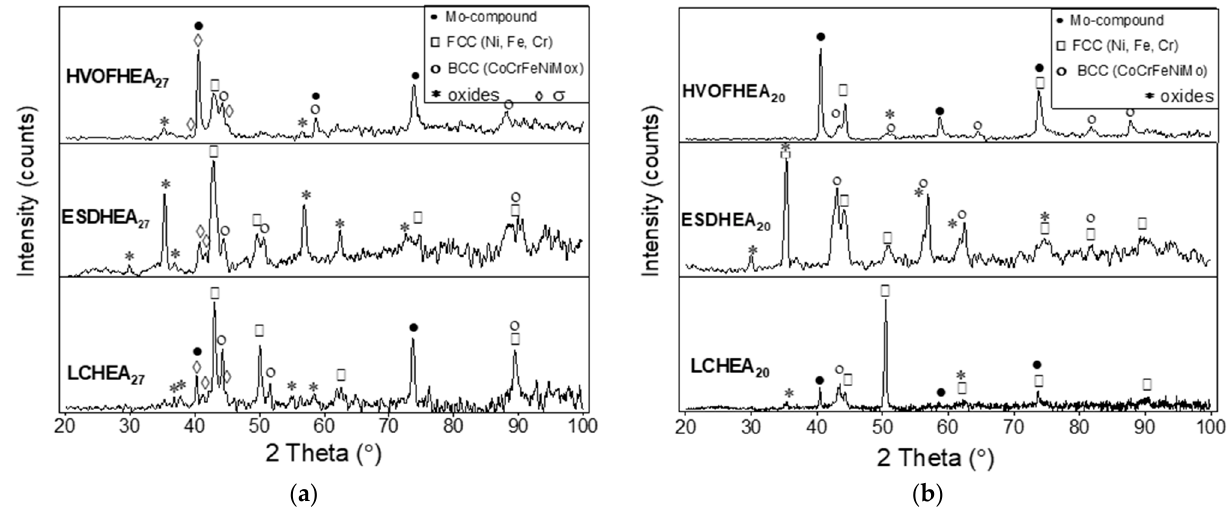
Figure 7. XRD scan of the as-sprayed ( a ) HEA_Mo 27 and ( b ) HEA_Mo 20 coatings with the different deposition techniques.